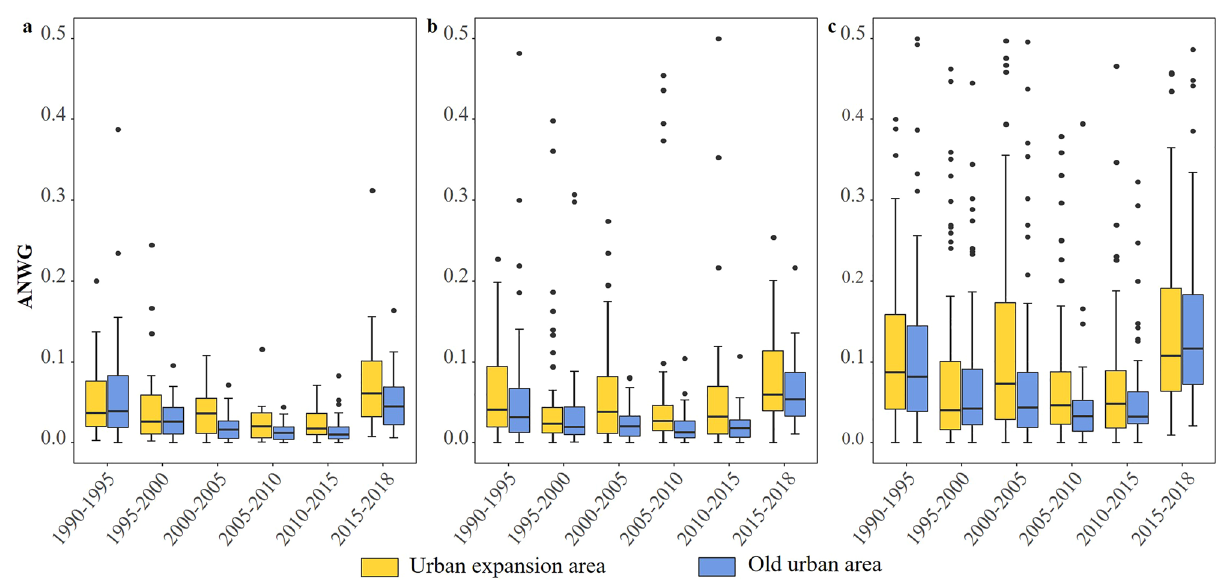
Figure 4. Box diagram showing ANWG index in urban expansion areas and old urban areas for ( a )–( c ) cities of Type I-III, respectively. For visual, some ANWG values above 0.5 in Type-III cities are not shown in the